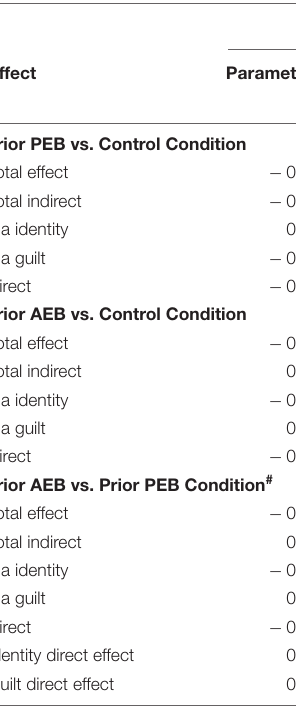
TABLE 1 | Standardized direct and indirect effects on PEB2